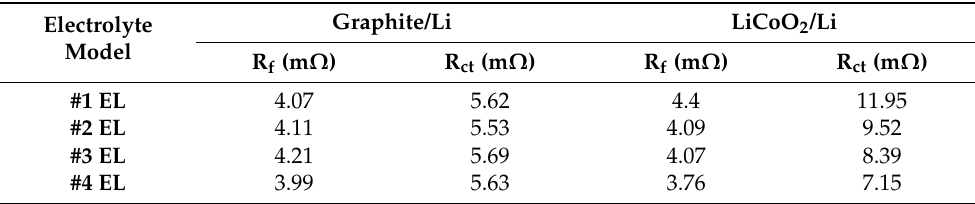
Figure 6. Discharge capacity retention (DCR) discharge at room temperature. 3.2.2. Effect of DDDT additive on high-temperature storage 100